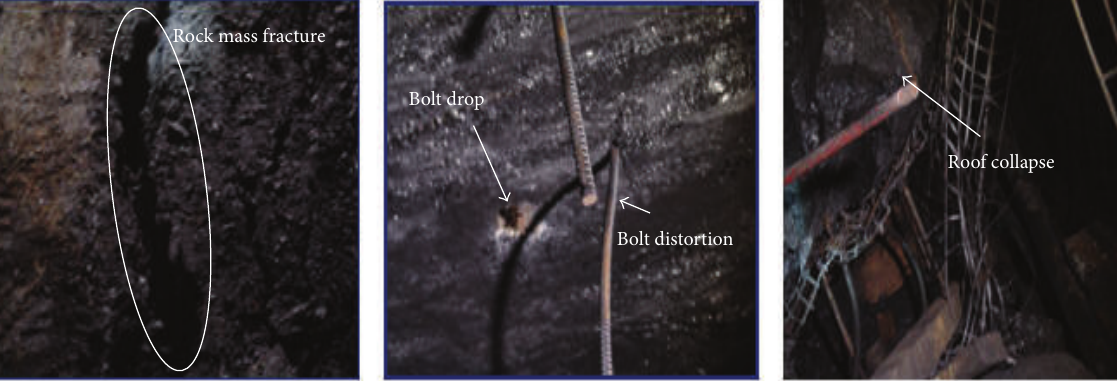
Figure 2: Field collapse and coal burst (2012.6.30).